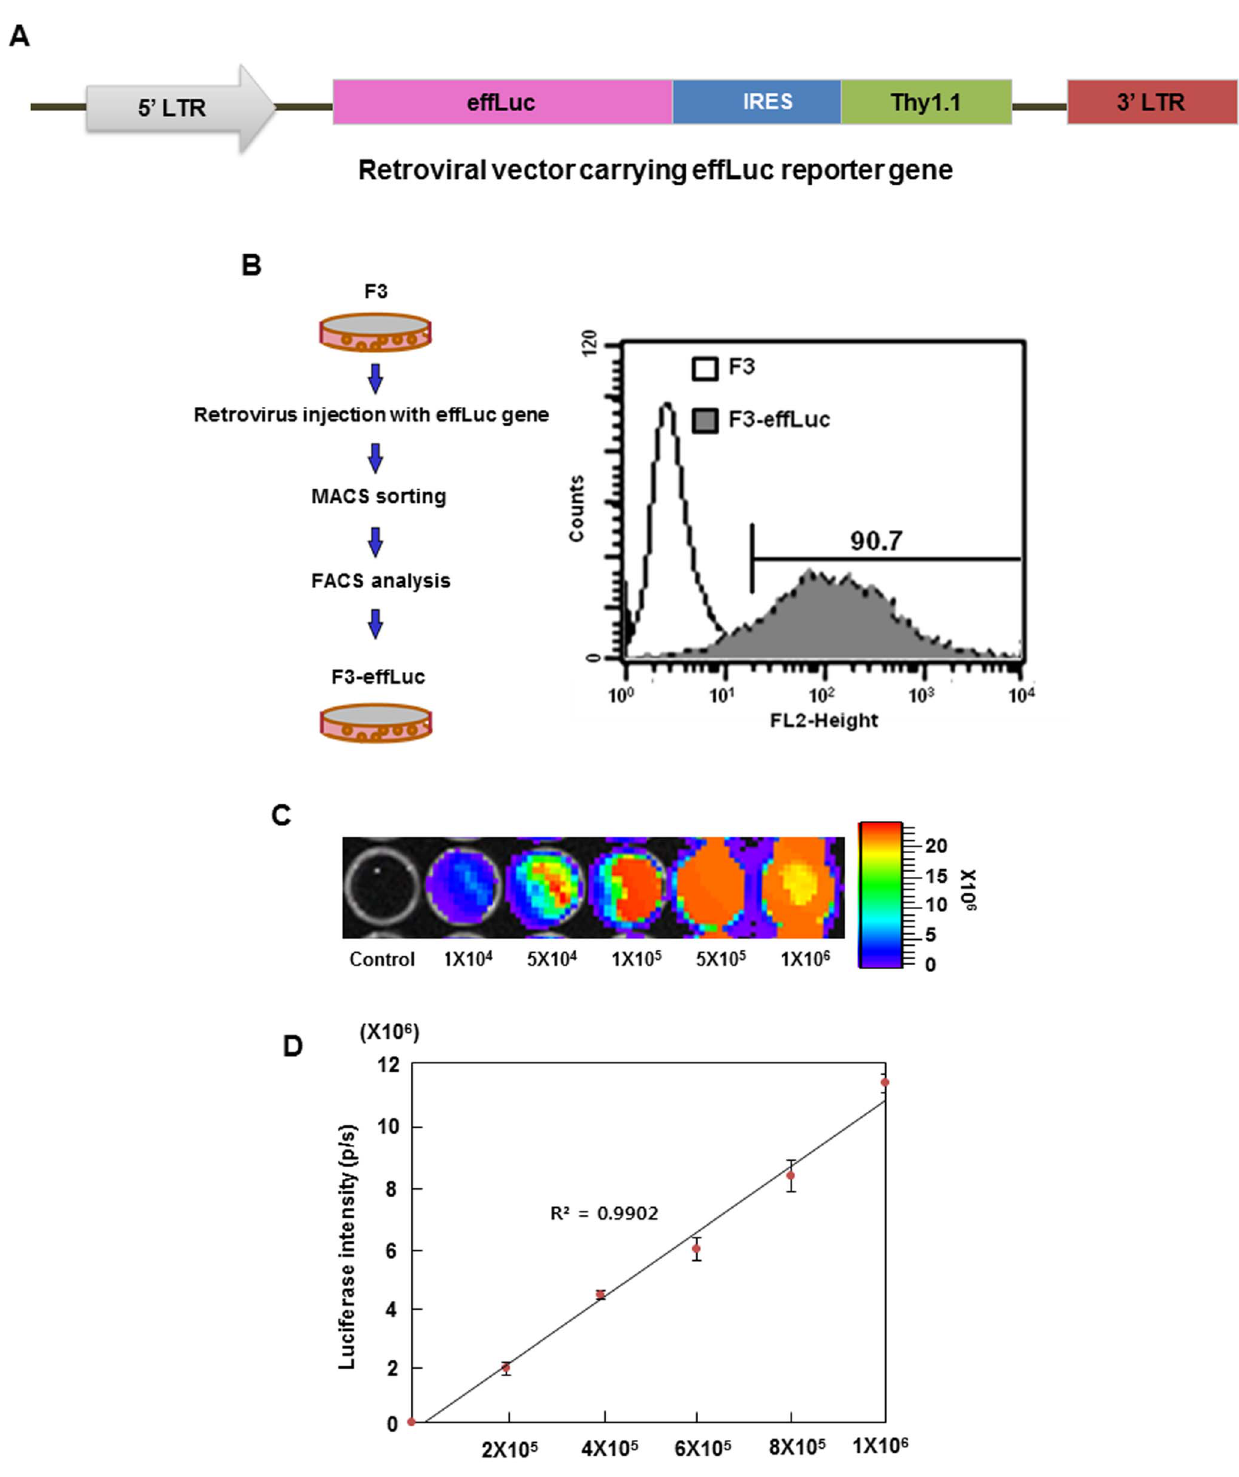
Figure 1. Invitro luciferase reporter activity in F3-effLuc cells. (A) Retroviral construct that contains the effLuc gene and Thy1.1 (CD90.1), linked with an IRES (internal ribosomal entry site). (B) Magnetic-activated cell sorting (MACS) was performed to collect the F3-effLuc cells. Flow activated cell sorting (FACS) analysis showed that more than 90% of cells were successively transfected with the effLuc vector. (C) The luciferase activity (n=3) of F3-effLuc cells cultured in a 96-well plate were measured using an IVIS-100 optical imaging device. Firefly luciferase activity continuously increased in F3-effLuc cells in proportion to cell number, and (D) quantitative analysis showed a linear relationship between the cell number and bioluminescence signals.